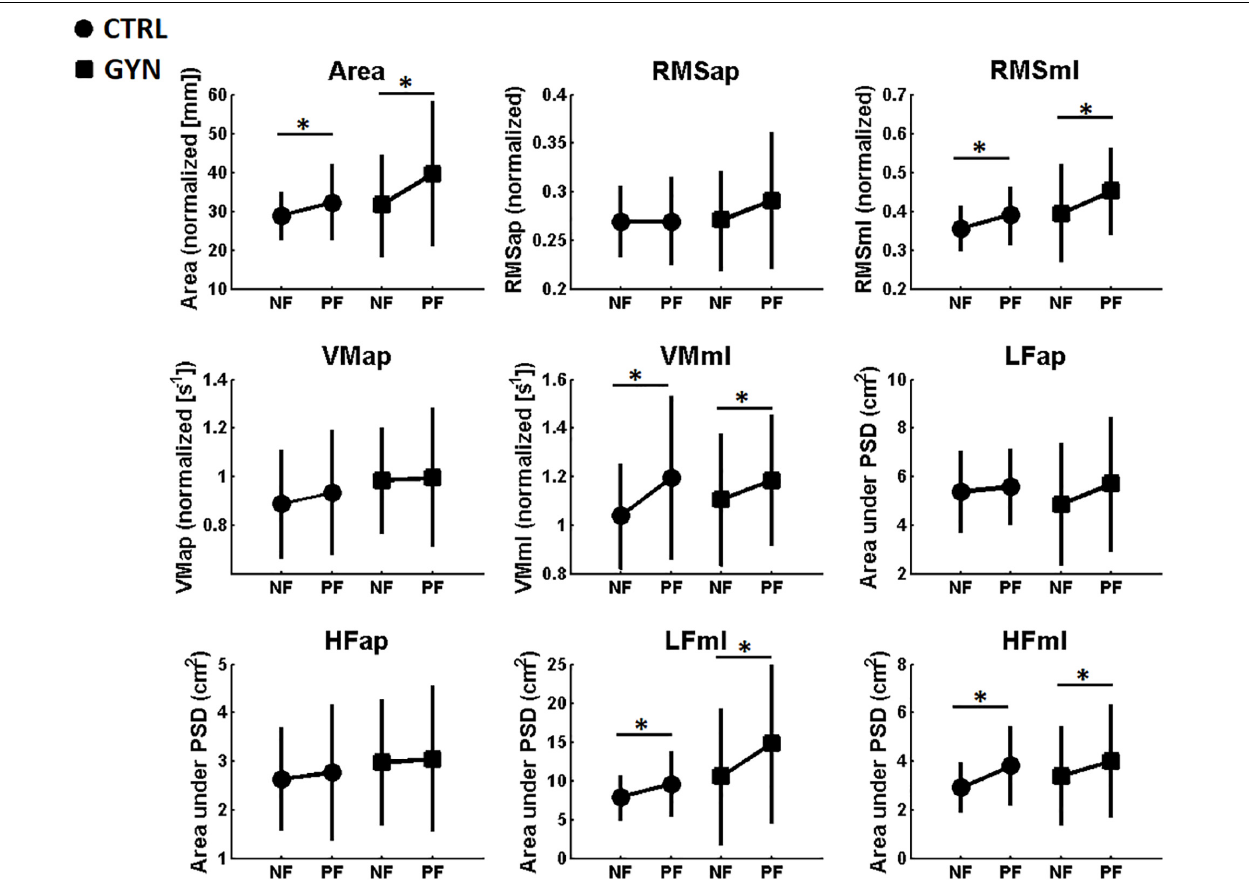
FIGURE 3 | Average center of pressure (COP) measures [associated with the AP (anterior posterior) and ML (medial-lateral) axis] computed before (NF, no fatigue) and after (PF, post-fatigue) the fatiguing protocol. Values associated with the CTRL and GYN groups are represented by circles and squares, respectively. ∗ indicate a statistically significant effect of the fatigue factor, that is, significant differences between NF and PF ( p < 0.05). Area: area of the area of the stabilogram, RMS: root mean square, VM: COP mean velocity, LF: low frequencies (LF, 0.05–0.5 Hz), HF: high frequencies.